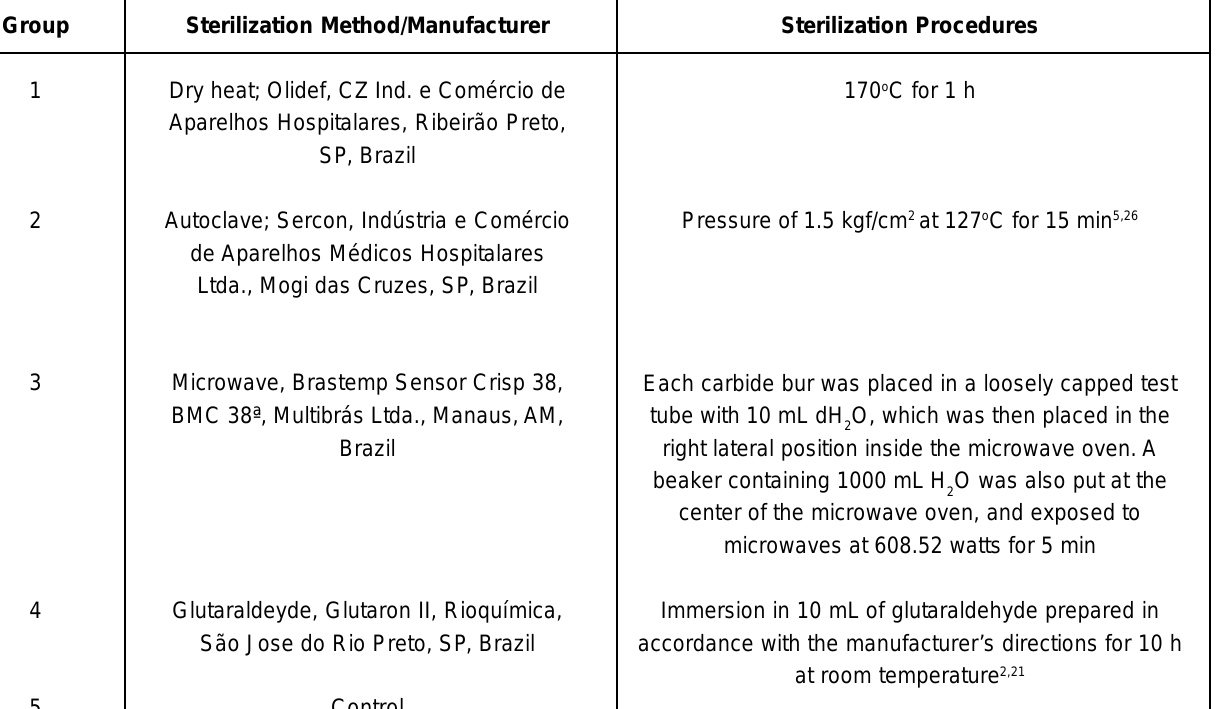
FIGURE 1- Experimental groups and sterilization characteristics. dH